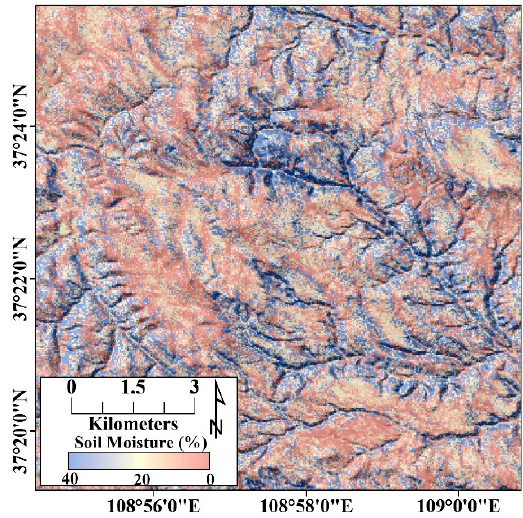
Figure 11. The map of volumetric soil moisture in the study area overlaying hillshade.